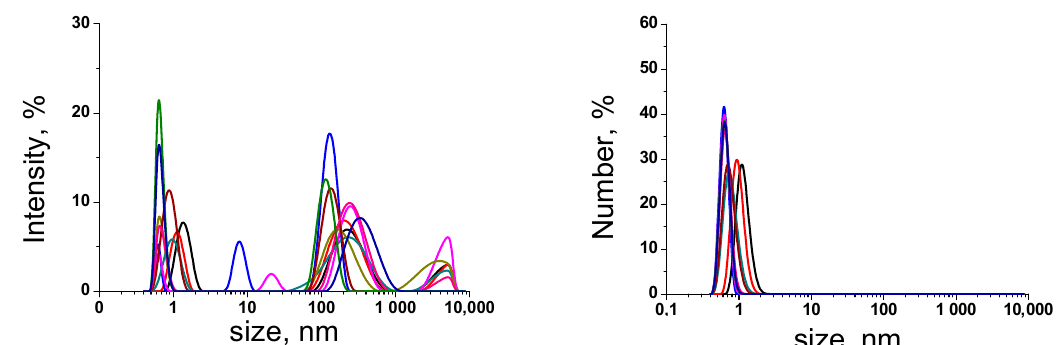
Figure 1. Some consecutive measurements of a particle size distribution by intensity (left) and by number (right) in 0.10 mol ∙ L ‒ 1 Na 2 SO 4 stock solution (Sample type B), detected by DLS; the green (first scan), blue, pink, red, brown, swamp green, dark blue, dark brown (last scan) bands correspond to the sequential measurements (scans), taken with 30 s delay one after another.